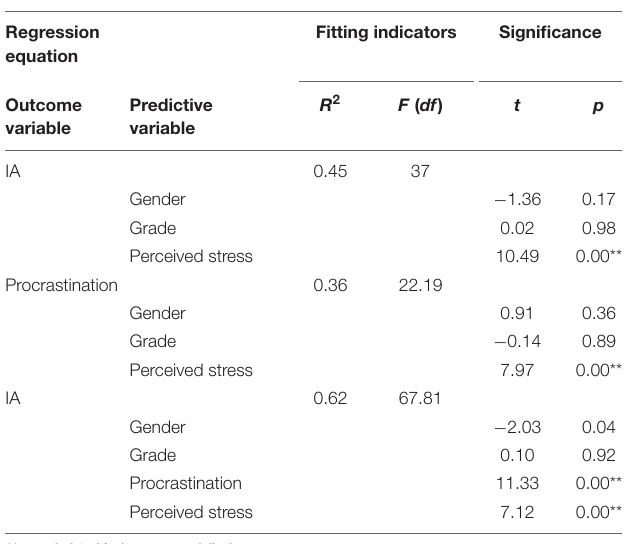
TABLE 2 | Mediation model test of procrastination.